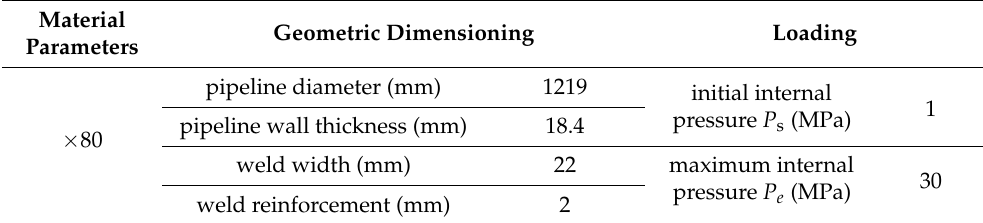
Table 1. Pipeline weld parameters.